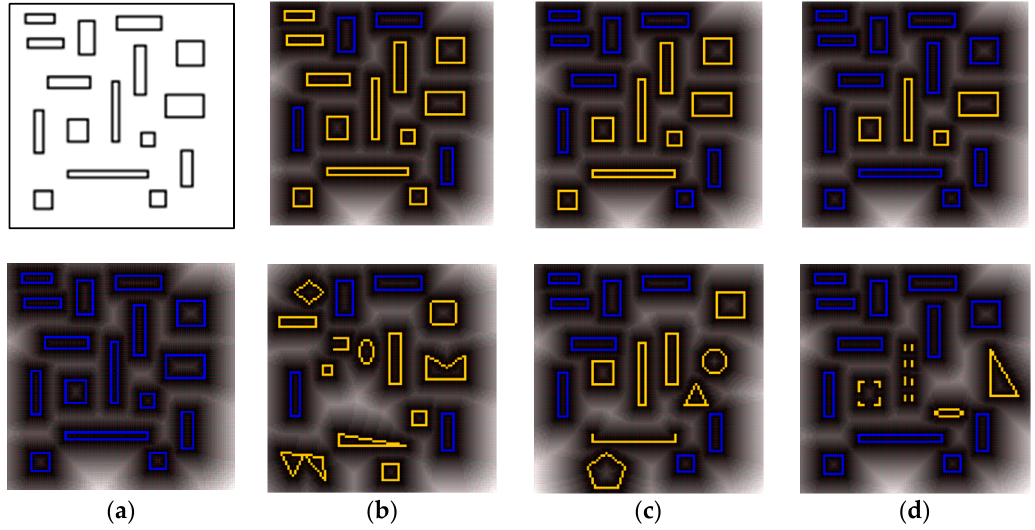
Figure 9. The grid maps used to compare performance of different algorithms. ( a ) Full reconstruction; ( b ) 75% changed; ( c ) 50% changed; ( d ) 25% changed. Within these figures, the obstacles marked in black and blue are static, while the obstacles marked in yellow randomly change their positions or shapes.